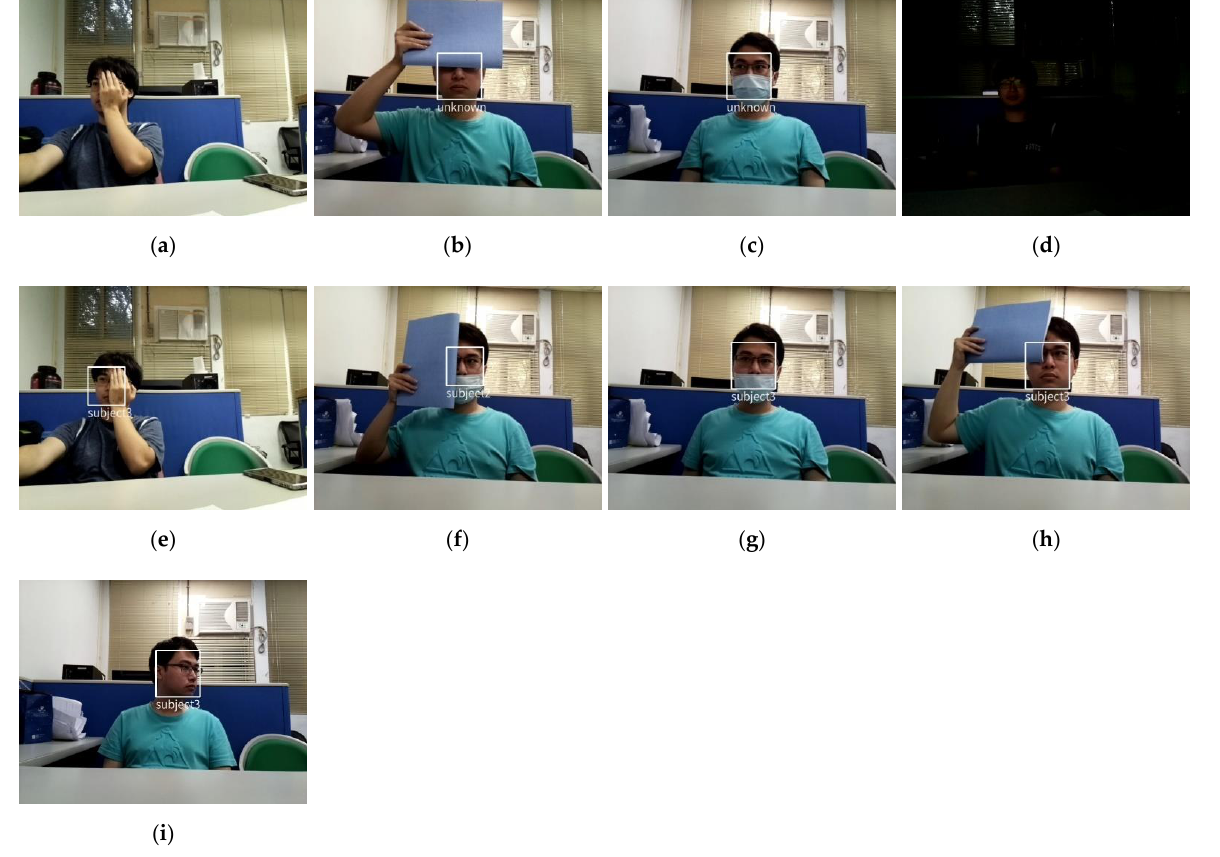
Figure 10. The performance of the proposed face detection and facial recognition methods under different masking and lighting conditions. ( a ) More than half of the facial features are covered. ( b ) Two eyes covered by a book. ( c ) Mouth and nose cover by a mask. ( d ) Environmental brightness is low. ( e ) Half of the facial features are covered. ( f ) Mouth and eye cover by a mask and book. ( g ) Mouth covered by mask. ( h ) One eye covered by a book. ( i ) Side profile.